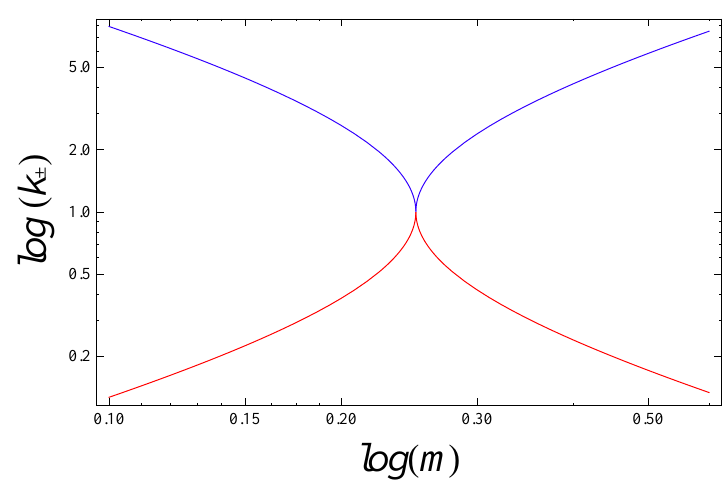
Figure 4. Upper/lower limits on the wave number, k + (blue) and k − (red), as functions of m